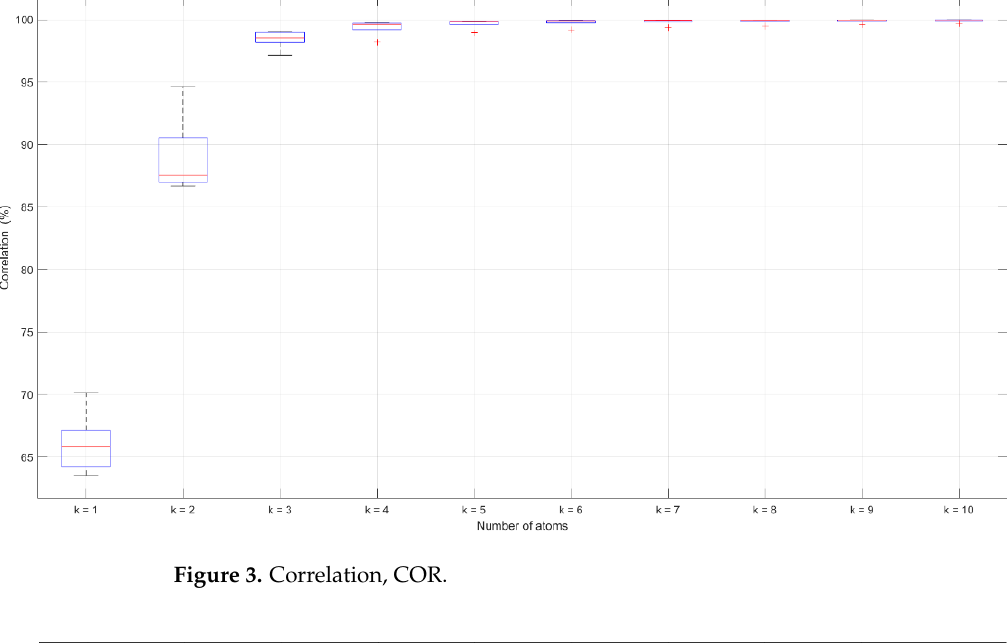
Figure 3. Correlation, COR.